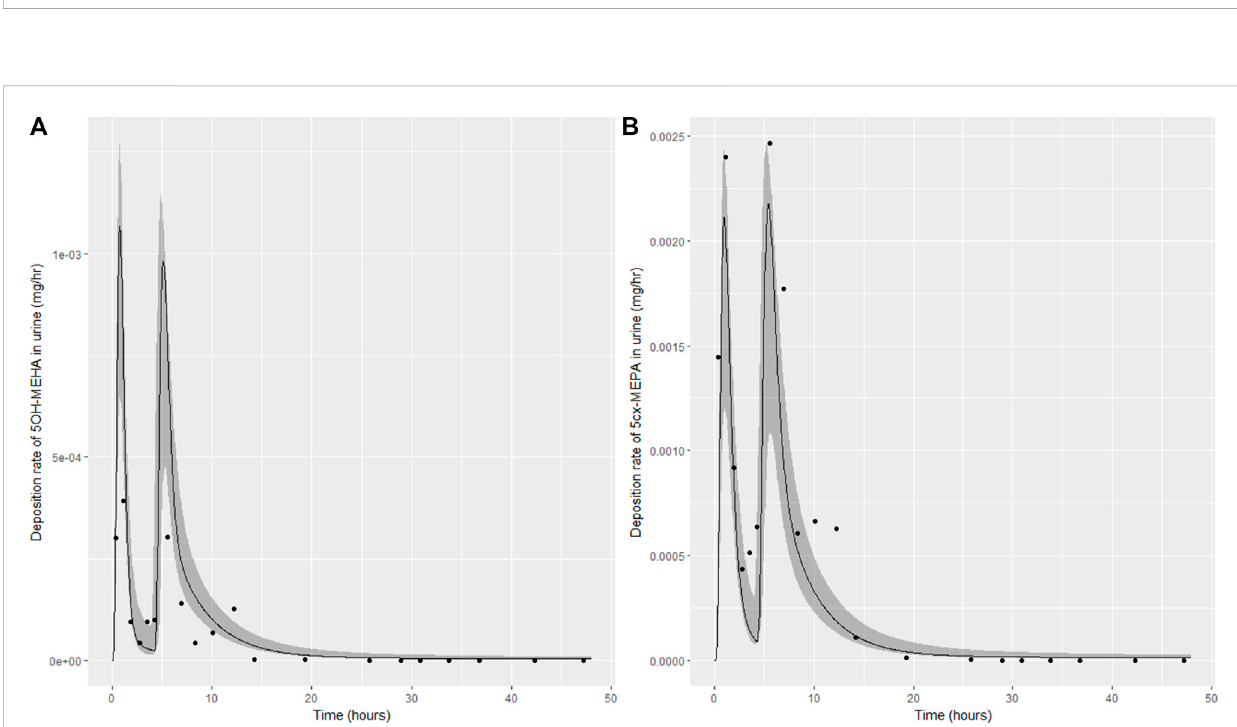
Simulation of the urinary excretion (mg/h) of 5OH-MEHA (A) and 5cx-MEPA (B) for volunteer